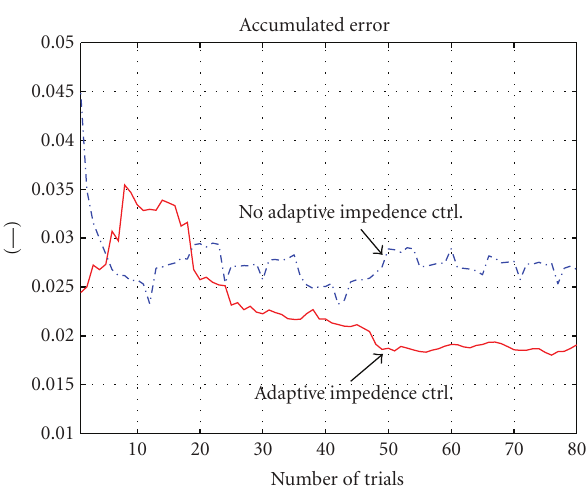
Figure 12: Evolution of accumulated error.